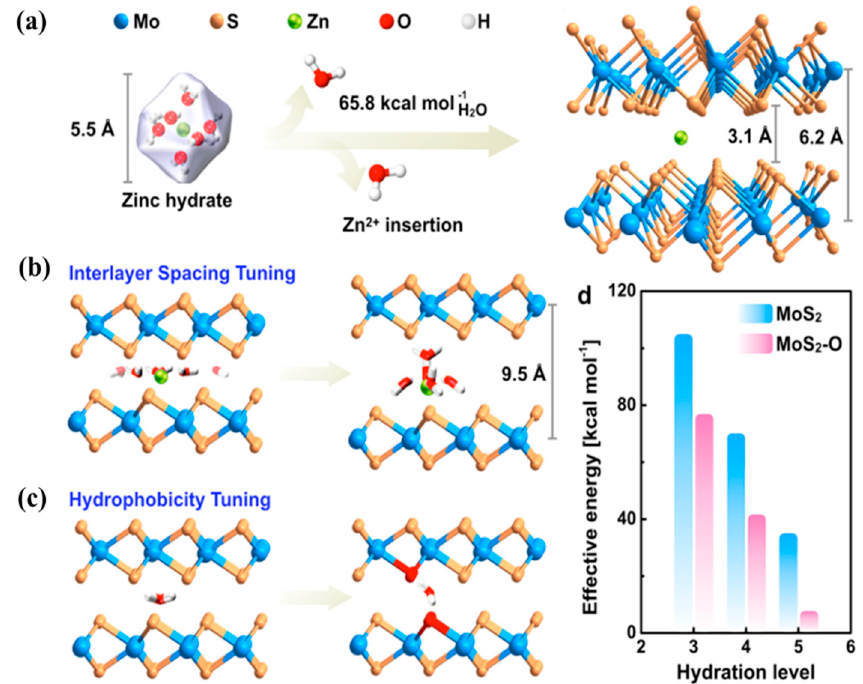
Figure 11. ( a ) Schematic showing the difficulty in the intercalation of Zn hydrates into bulk MoS 2 owing to the large energy barrier between the layers, ( b ) the expanded interlayer distance that sup- ports the diffusion of Zn 2+ , ( c ) hydrophobicity control by the Zn–H 2 O–O interaction, ( d ) theoretical energy barrier between MoS 2 and MoS 2 –O depending on the hydration level of Zn 2+ . Reprinted with permission from Liang et al. [77] Copyright 2019, American Chemical Society.